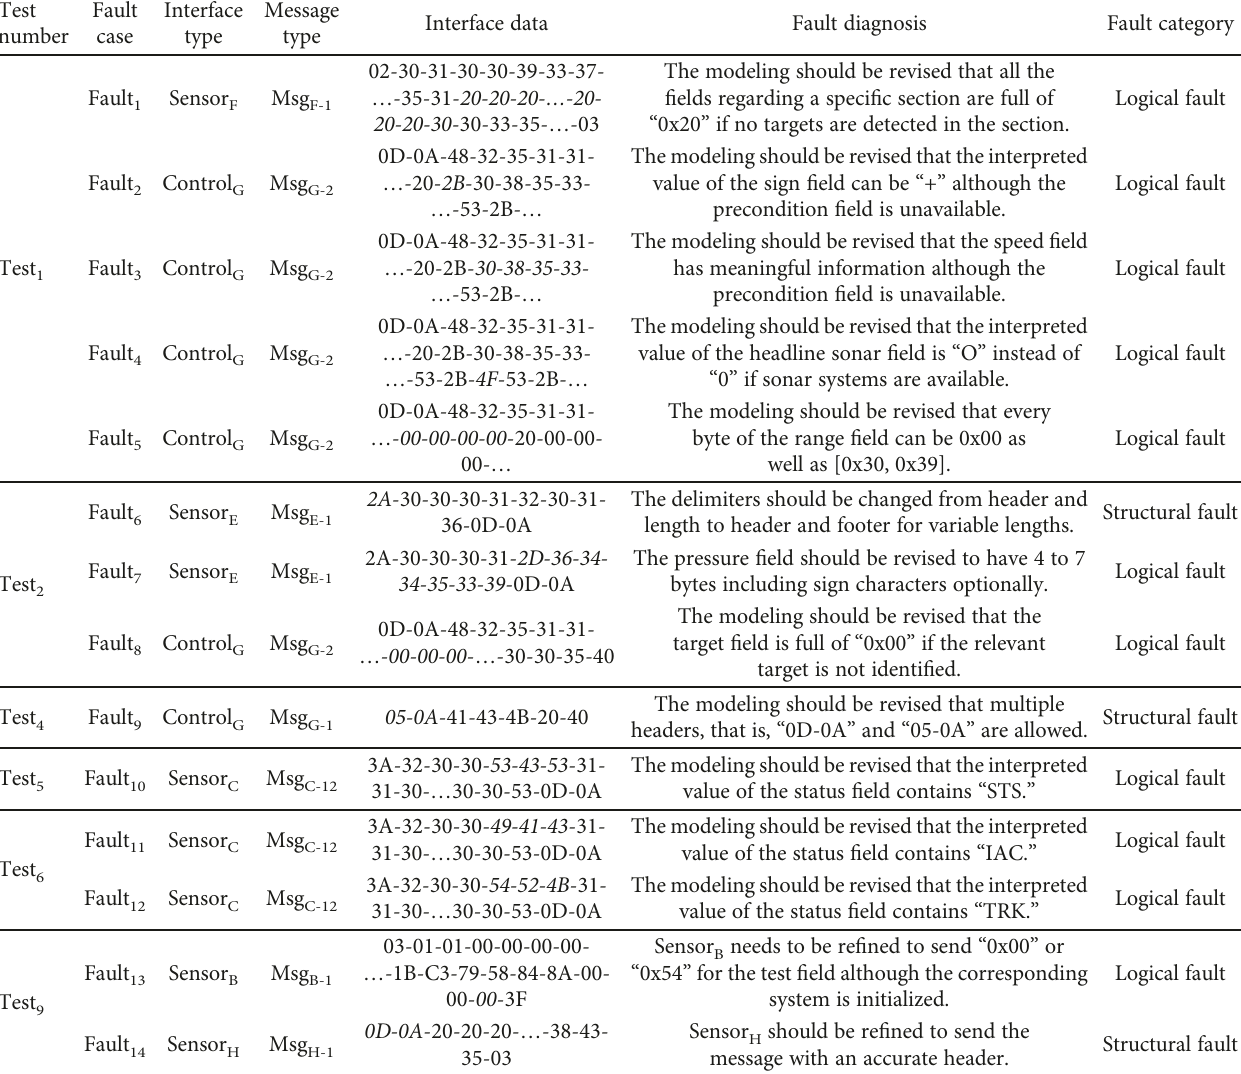
Table 8: Overall test results: fault-diagnosis